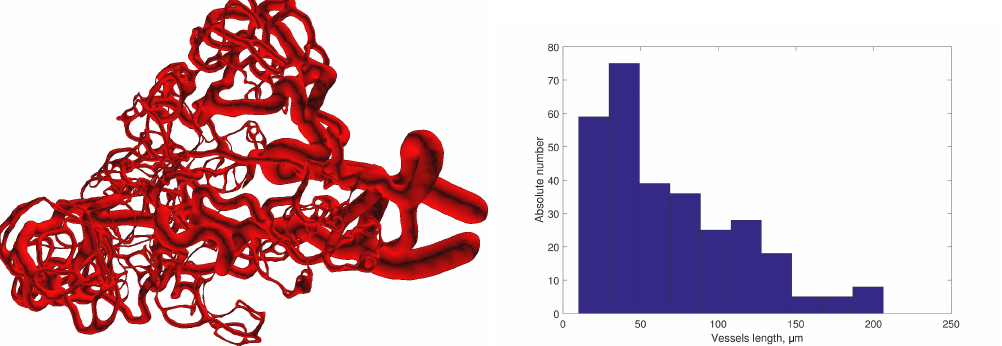
Figure 3. ( left ) An artificially generated 3D blood vessel network (for a sphere with a diameter of about 200 µ m); ( right ) Vessels length distribution of the computationally constructed blood